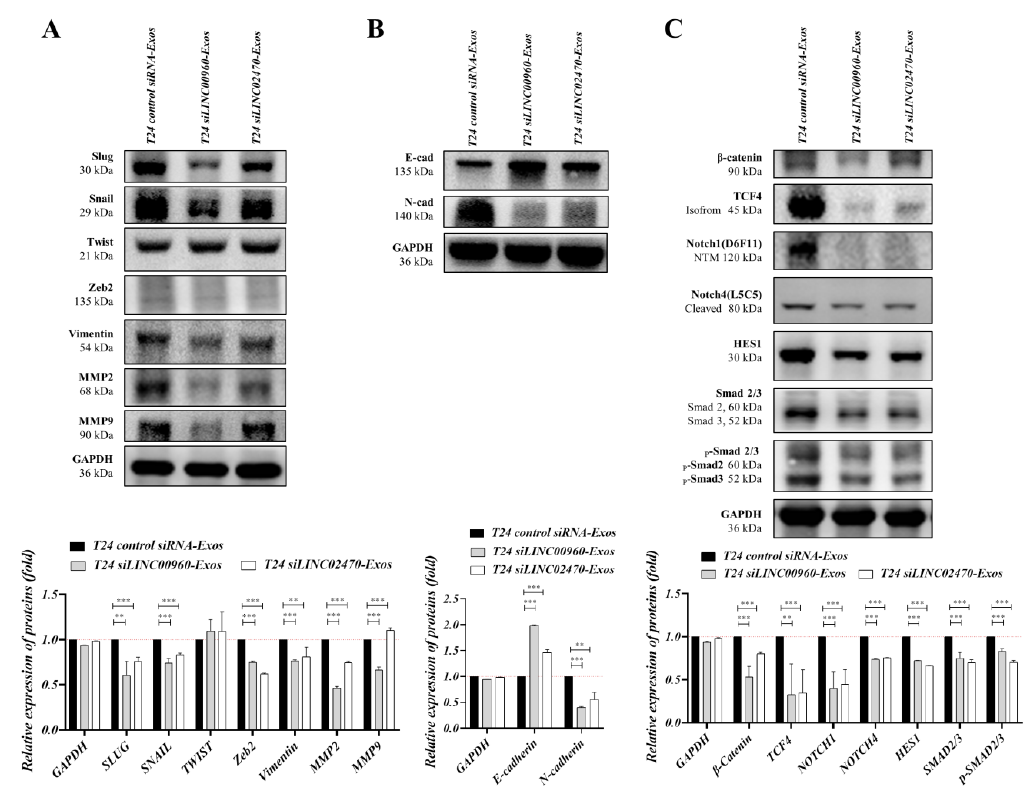
Figure 8. Exosomes derived from LINC00960-knockdown or LINC02470-knockdown T24 cell reduced the expression levels of EMT-related molecules in recipient TSGH-8301 cells. ( A ) Protein expression levels of EMT effectors: Snail, Slug, Twist, Zeb2, vimentin, MMP2, MMP9, ( B ) E -Cadherin and N -Cadherin, and ( C ) EMT-induced signaling molecules: β -catenin, TCF4, Notch1, Notch4, HES1, Smad2/3 and p-Smad2/3 were compared after treatment with each exosome. The bar-charts showed the mean and SD of triplicate experiments, * p < 0.05, ** p < 0.01, *** p < 0.001.